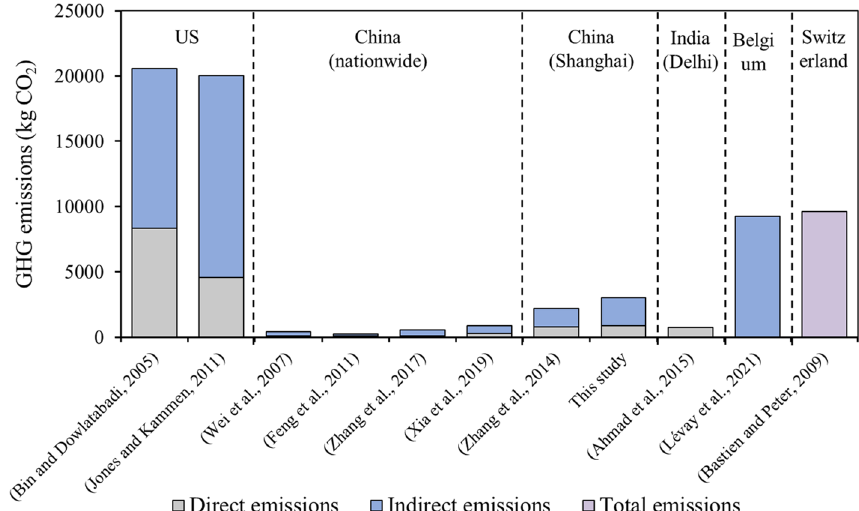
Fig. 8 Summary of P GHG emissions in different